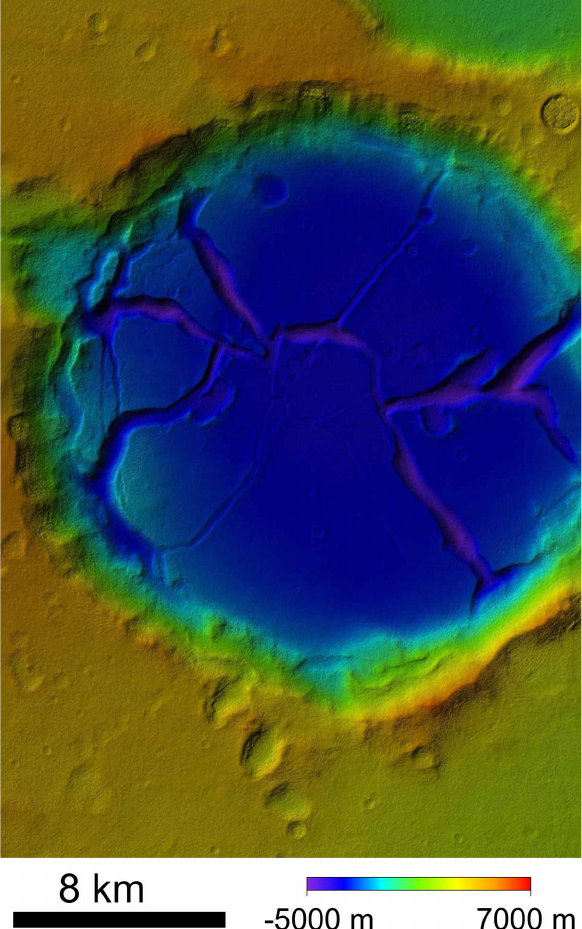
Figure 8. Sample CTX DTM derived using CASP-GO created from G01_018584_1794_XN_00S050W- G02_019085_1794_XN_00S050W.